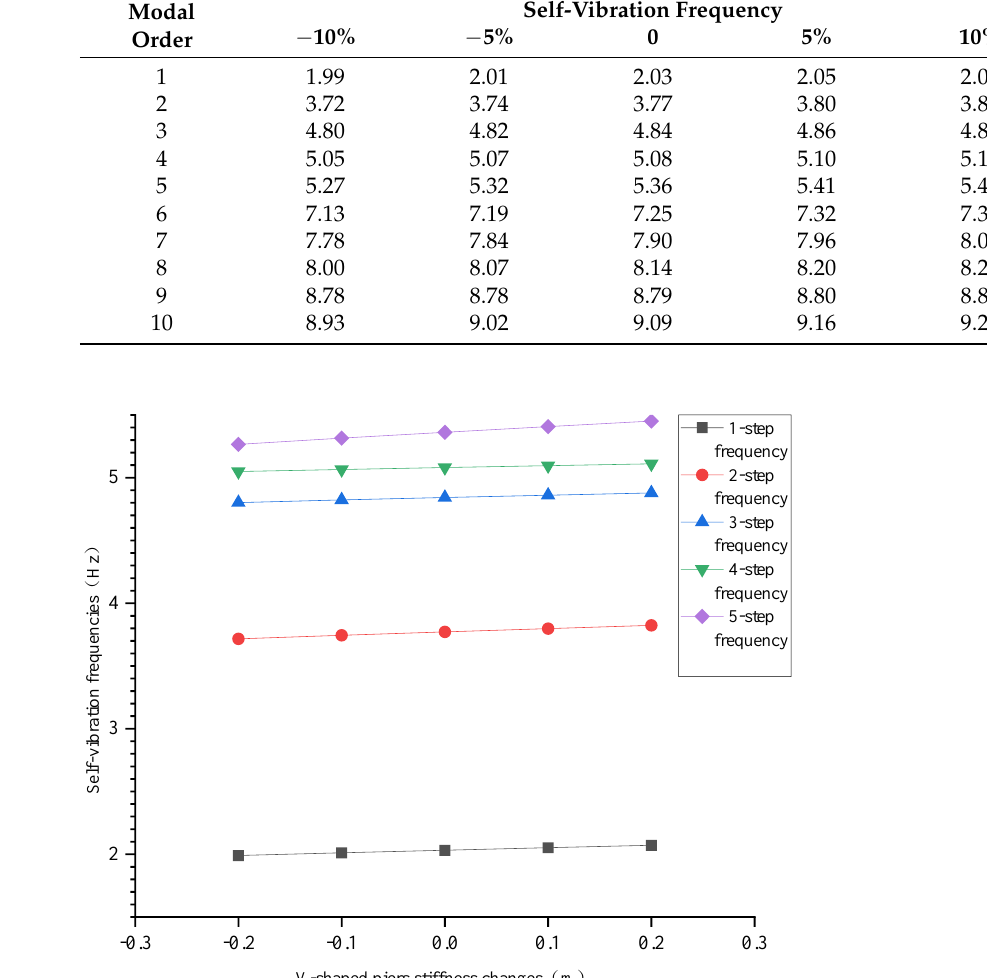
Table 10. Effect of shear-resistant connectors on the self-vibration frequencies of the original struc- ture.